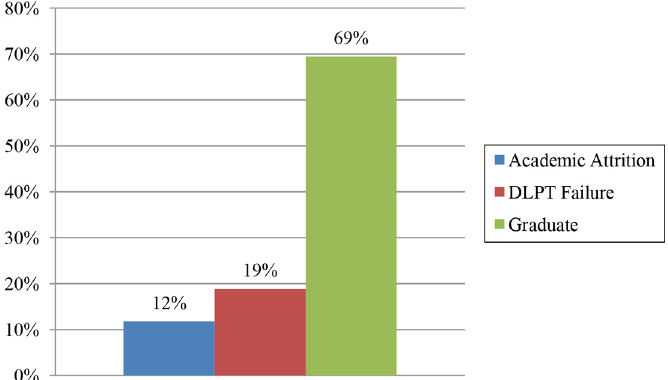
distribution of all Korean student outcomes at DLI from FY 2006 through FY 2013 after removing administrative attrition from the data